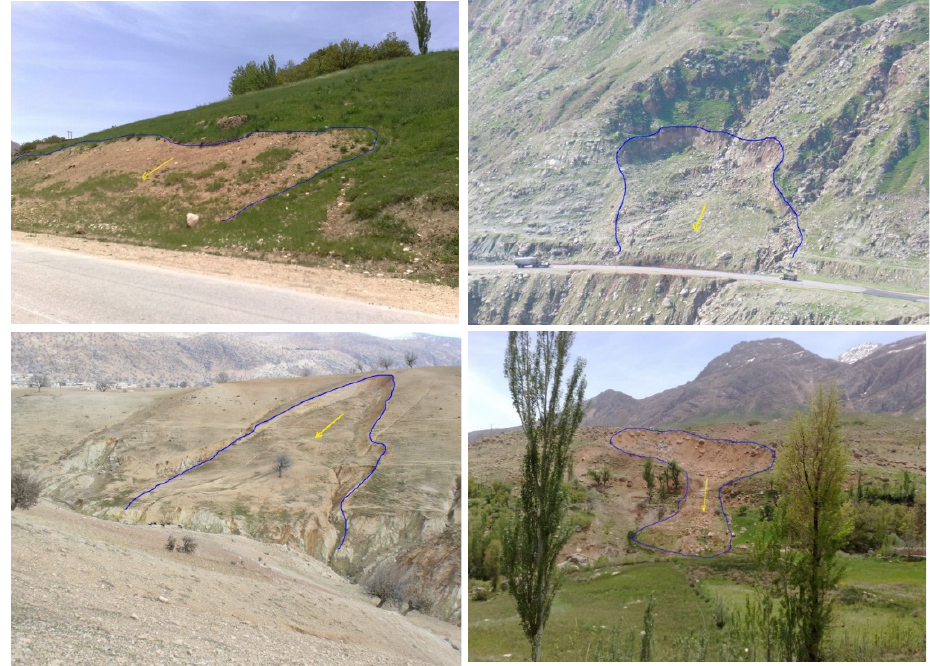
Figure 2. Examples of landslides in the study area [58].